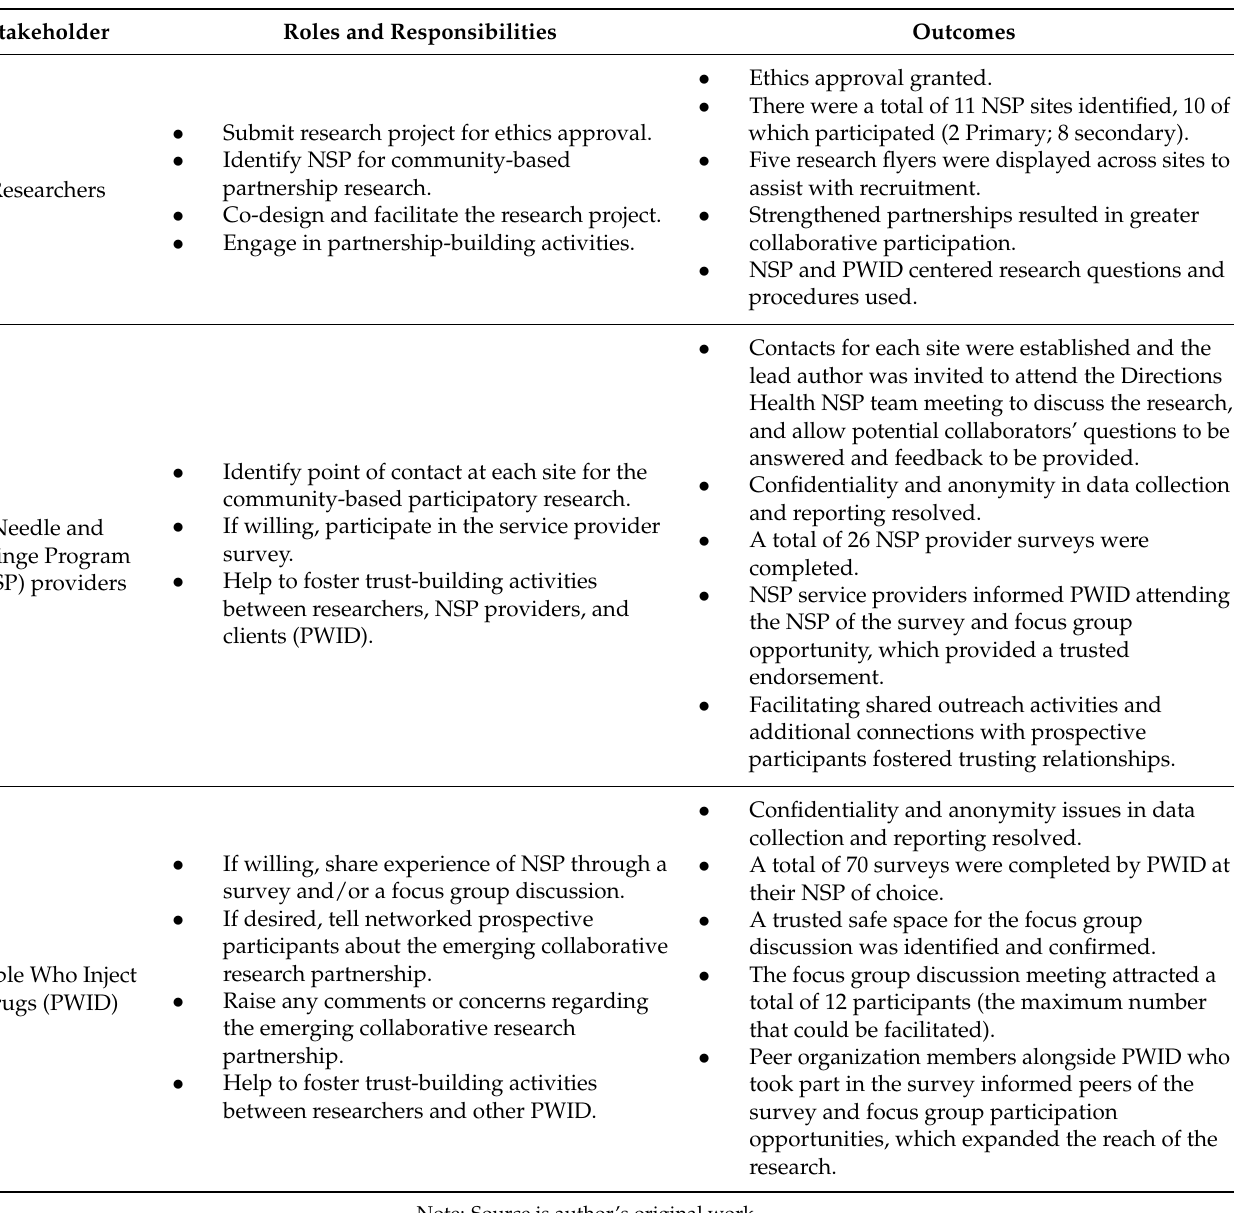
Table 4. Role and responsibility assignments and